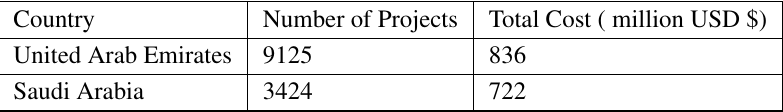
Table 1. Details of current Construction Projects in the